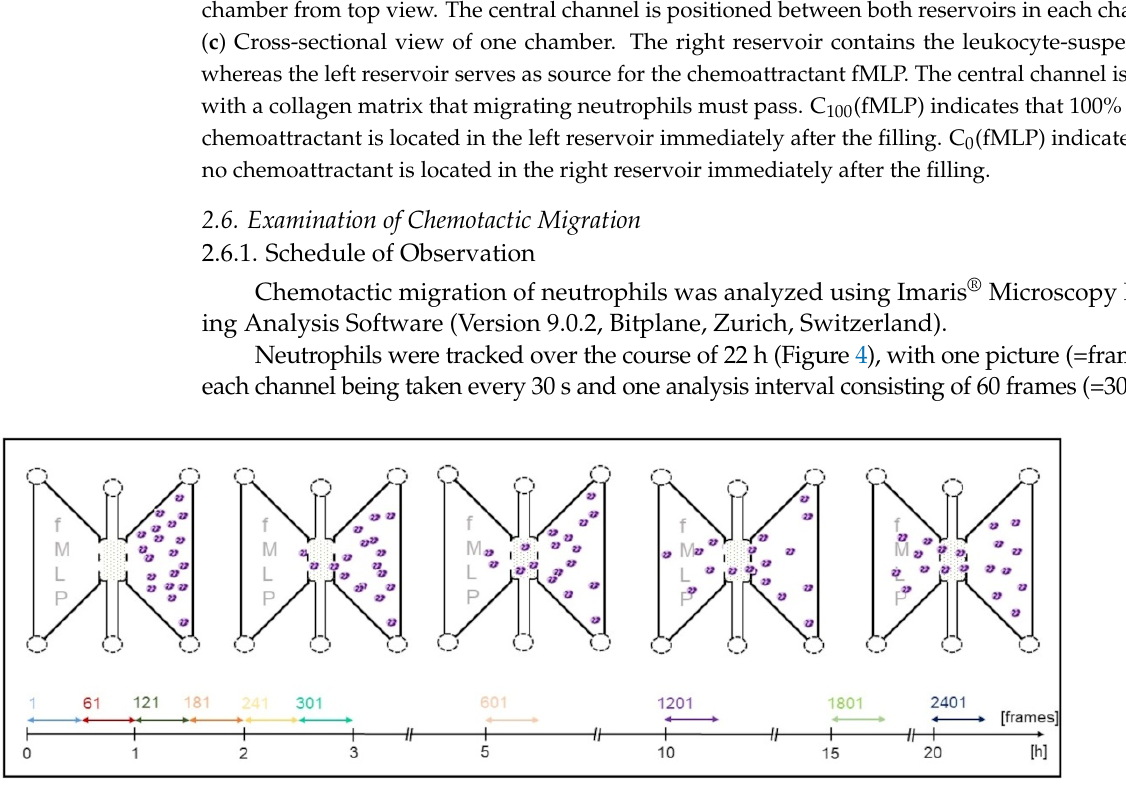
Figure 4 . Correlation between analysis interval, start frame and time of observation. Each double arrow represents one analysis interval (=60 frames) and is labeled after its first frame (=start